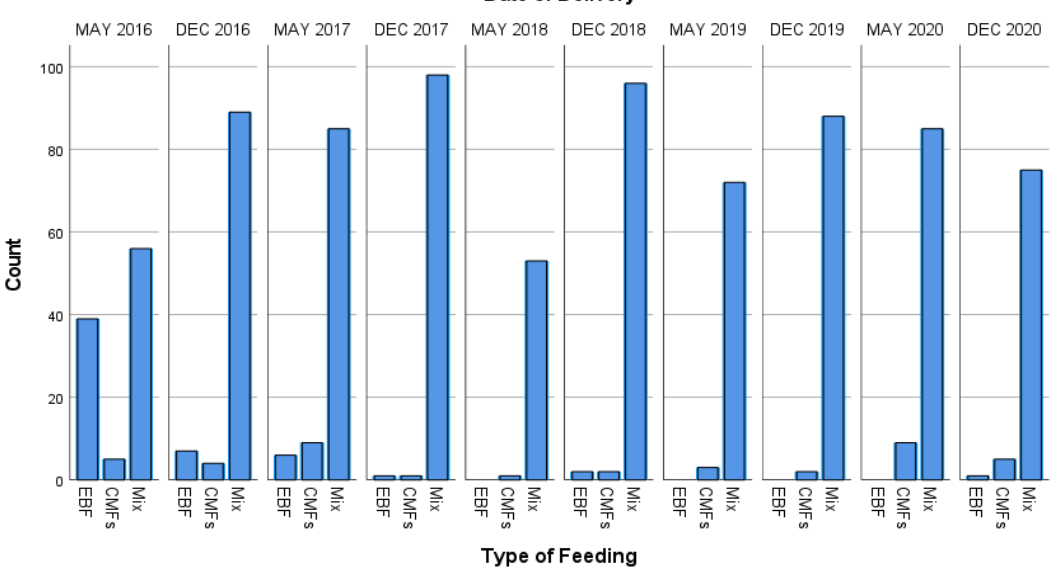
Figure 2. Number of patterns of feeding per month.